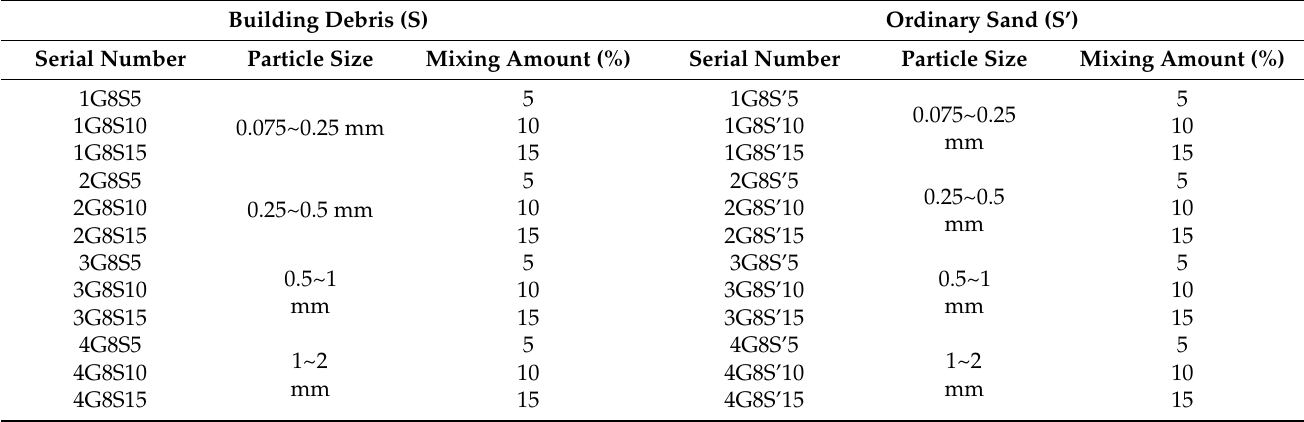
Table 1. Ratio of solidified